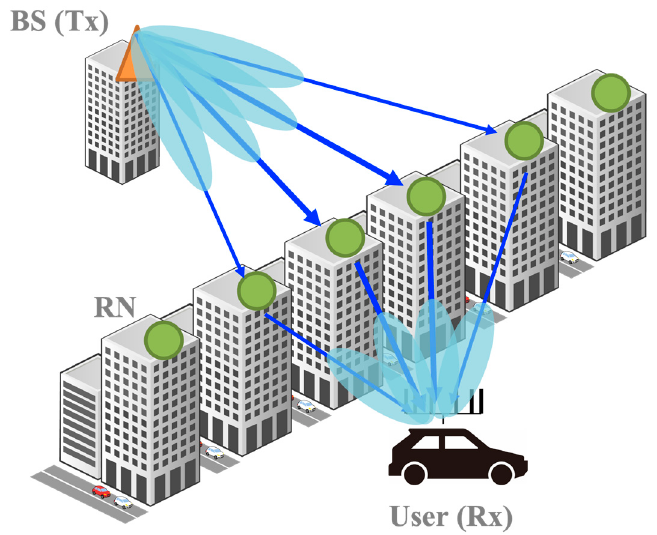
Figure 1. System model of the massive analog-relay MIMO in V2X applications.